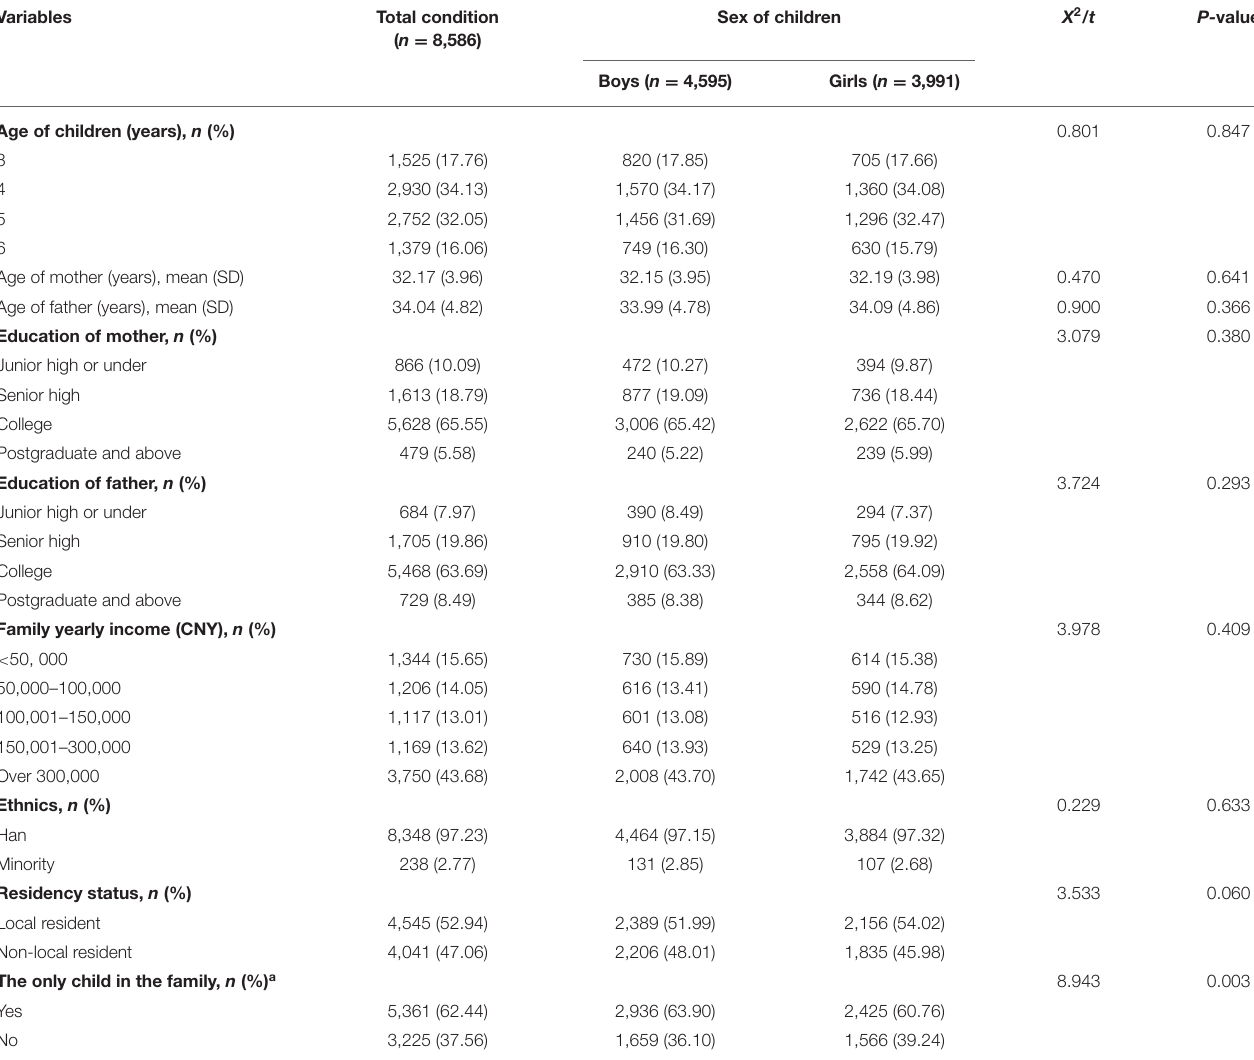
TABLE 1 | The demographic features of children aged 3–6 years and their parents in a rural area of Shanghai, China, in 2018 ( n = 8,586).